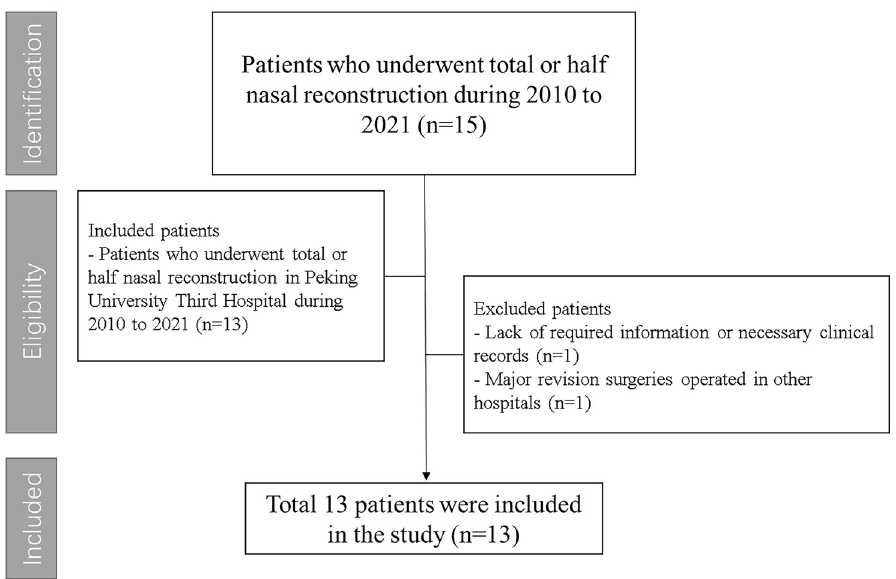
Figure 1. Inclusion and exclusion process of patients in this study.